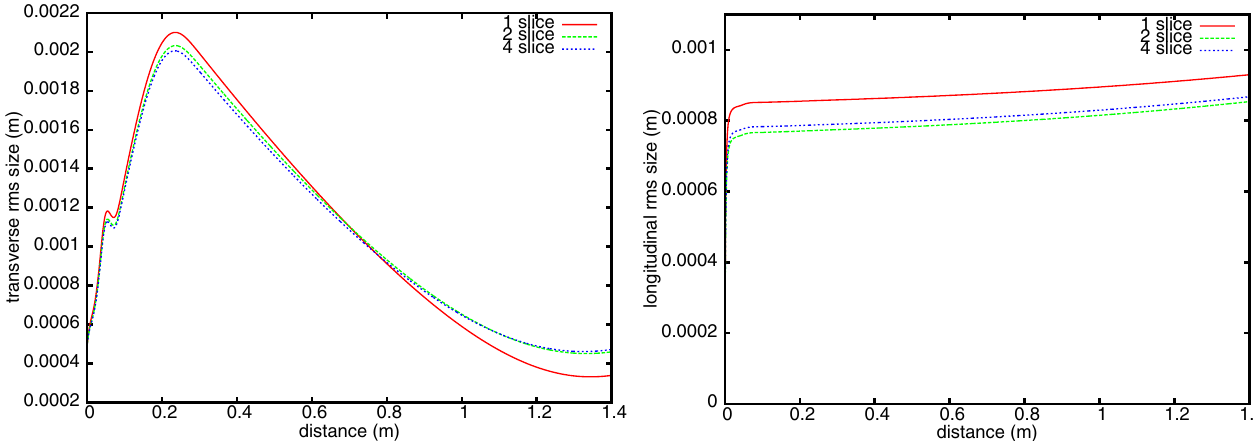
FIG. 9. (Color) Transverse (left) and longitudinal (right) rms sizes as a function of distance using one, two and four slices in the